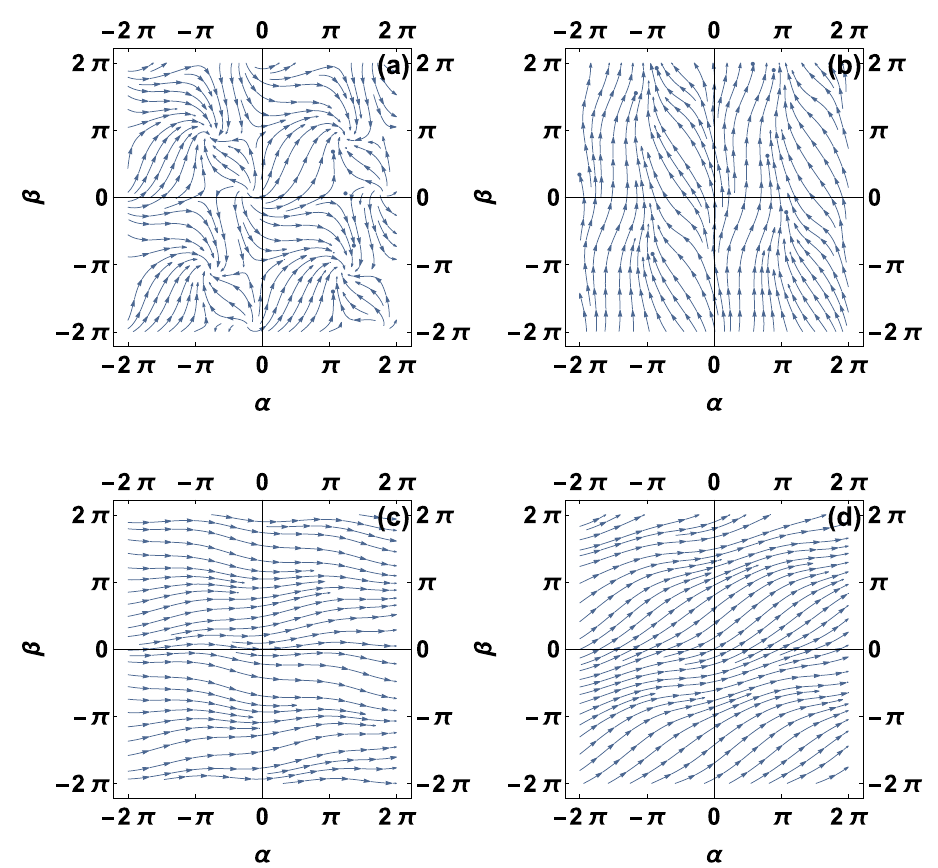
Fig. 10 Streamplots of the dynamical equations of Dirac synchronization. Streamplots of Eq. (27), for X α = R α = 0.8 ( ~ Ω ¼ 0) and σ = 2. The four different streamplots corresponds to nodes with frozen phases ( a ) ω = 1, ^ ω ¼ 0 : 5, to nodes with α -oscillating phases ( b ) ω = 1, ^ ω ¼ (cid:3) 3 : 5, to nodes with β - oscillating phases ( c ) ω = 8, ^ ω ¼ 8, to nodes with drifting phases ( d ) ω = 7, ^ ω ¼